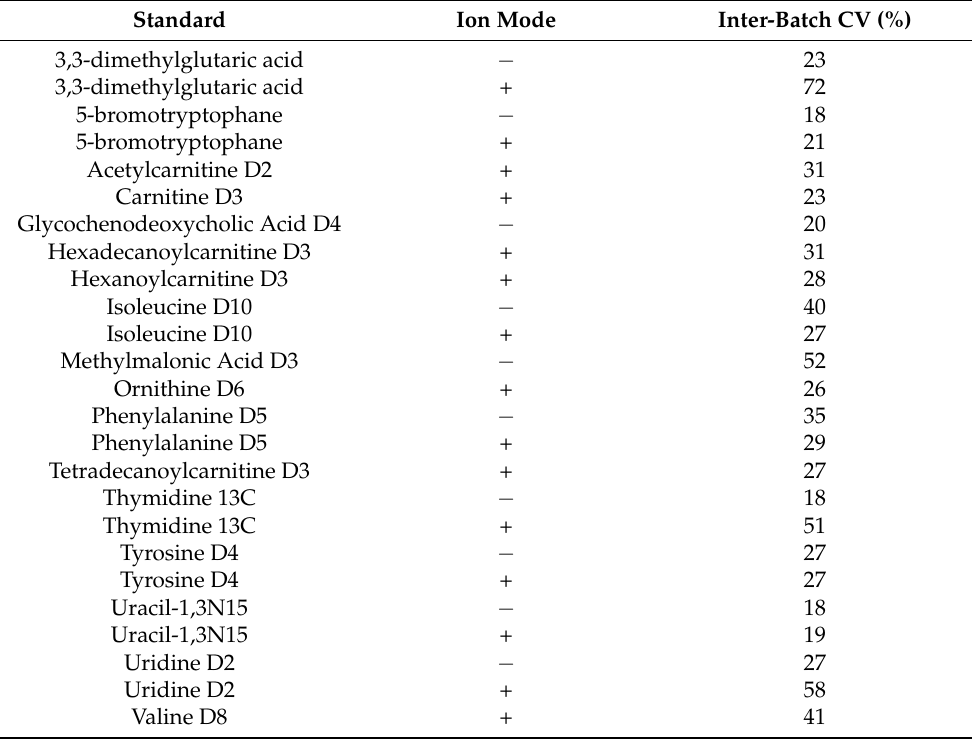
Table A1. Inter-batch Coefficients of Variation per standard based on 9 batches. Note, that some components were detected in both ion modi but the best CV was considered for quality control. Peak areas were determined using Xcalibur 4.0.